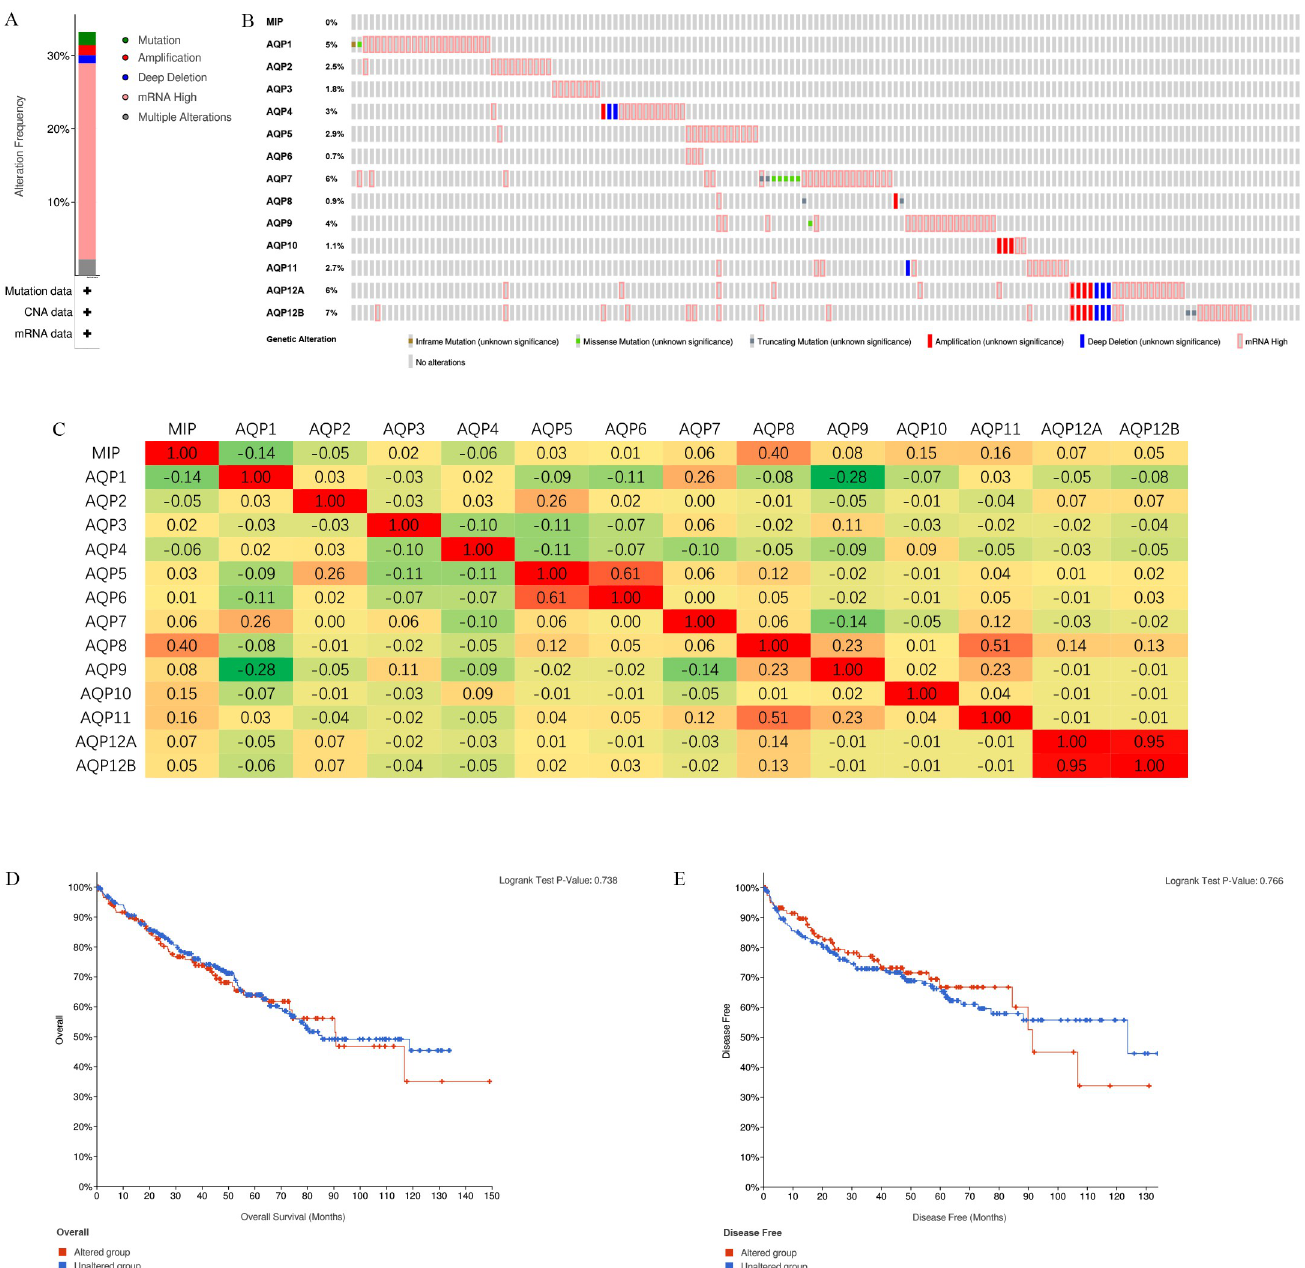
Fig 5. Genetic mutations in AQPs and their association with the OS and DFS of ccRCC patients (cBioPortal). ( A ) The bar plot showed the overall alterations of AQPs in the ccRCC samples. The vertical axis represented the percentage of alterations, and the horizontal axis represented the selected tumor sample dataset (ccRCC). Among them, the green indicated mutation, the red was amplification, the blue was deep deletion, the pink was high mRNA expression, and the gray was multiple alterations. A high mutation rate (33.18%) could be observed in ccRCC patients. ( B ) Based on a query of AQPs, cBioPortal summarized genomic alterations in all queried genes across the ccRCC sample set. Each row represented a gene, and each column represented a tumor sample. Brown squares indicated inframe mutations, green squares were missense mutations, gray squares were truncating mutations, red bars were gene amplifications, blue bars were deep deletions, and gray bars with red borders were high mRNA expressions. Mutation rates of each gene were 0%, 5%, 2.5%, 1.8%, 3%, 2.9%, 0.7%, 6%, 0.9%, 4%, 1.1%, 2.7%, 6% and 7%, respectively. ( C ) The figure showed the correlation between AQPs in ccRCC. For each queried gene, Pearson’s correlation coefficients were calculated and displayed in the corresponding boxes. ( D, E ) The figure indicated the survival difference between altered and unaltered groups. Genetic alterations of AQPs were not associated with the OS or DFS of ccRCC patients.